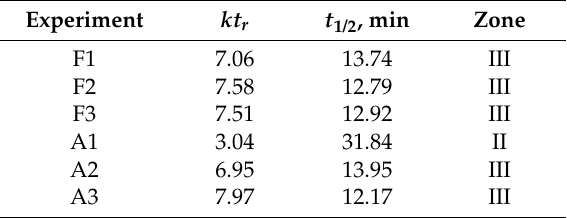
Table 4. Sorption kinetic parameter ( kt r ), t 1/2 and zone of the sorption